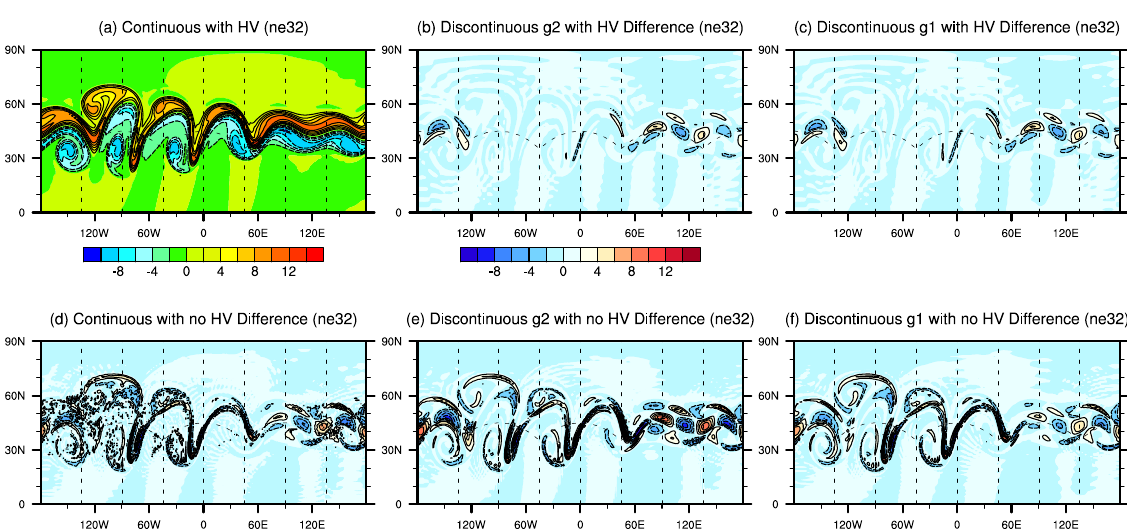
Figure 10. Relative vorticity field with n e = 32 and n p = 4 at day 6 for the barotropic instability test with (a) continuous elements and hyperviscosity (reference solution). Relative vorticity difference plot from reference solution with n e = 16 at day 6 for (b) discontinuous g 2 elements with hyperviscosity, (c) discontinuous g 1 elements with hyperviscosity, (d) continuous elements without hyperviscosity, (e) dis- continuous g 2 elements without hyperviscosity and (f) discontinuous g 1 elements without hyperviscosity. The time step used for these runs was (a, d) (cid:49)t = 150s, (b, e) (cid:49)t = 75s and (c, f) (cid:49)t = 50s. Discontinuous penalization was used for both discontinuous schemes. Contour spacing in all plots is 2 × 10 − 5 s − 1 with the zero line removed. Long dashed lines show the cubed-sphere grid.